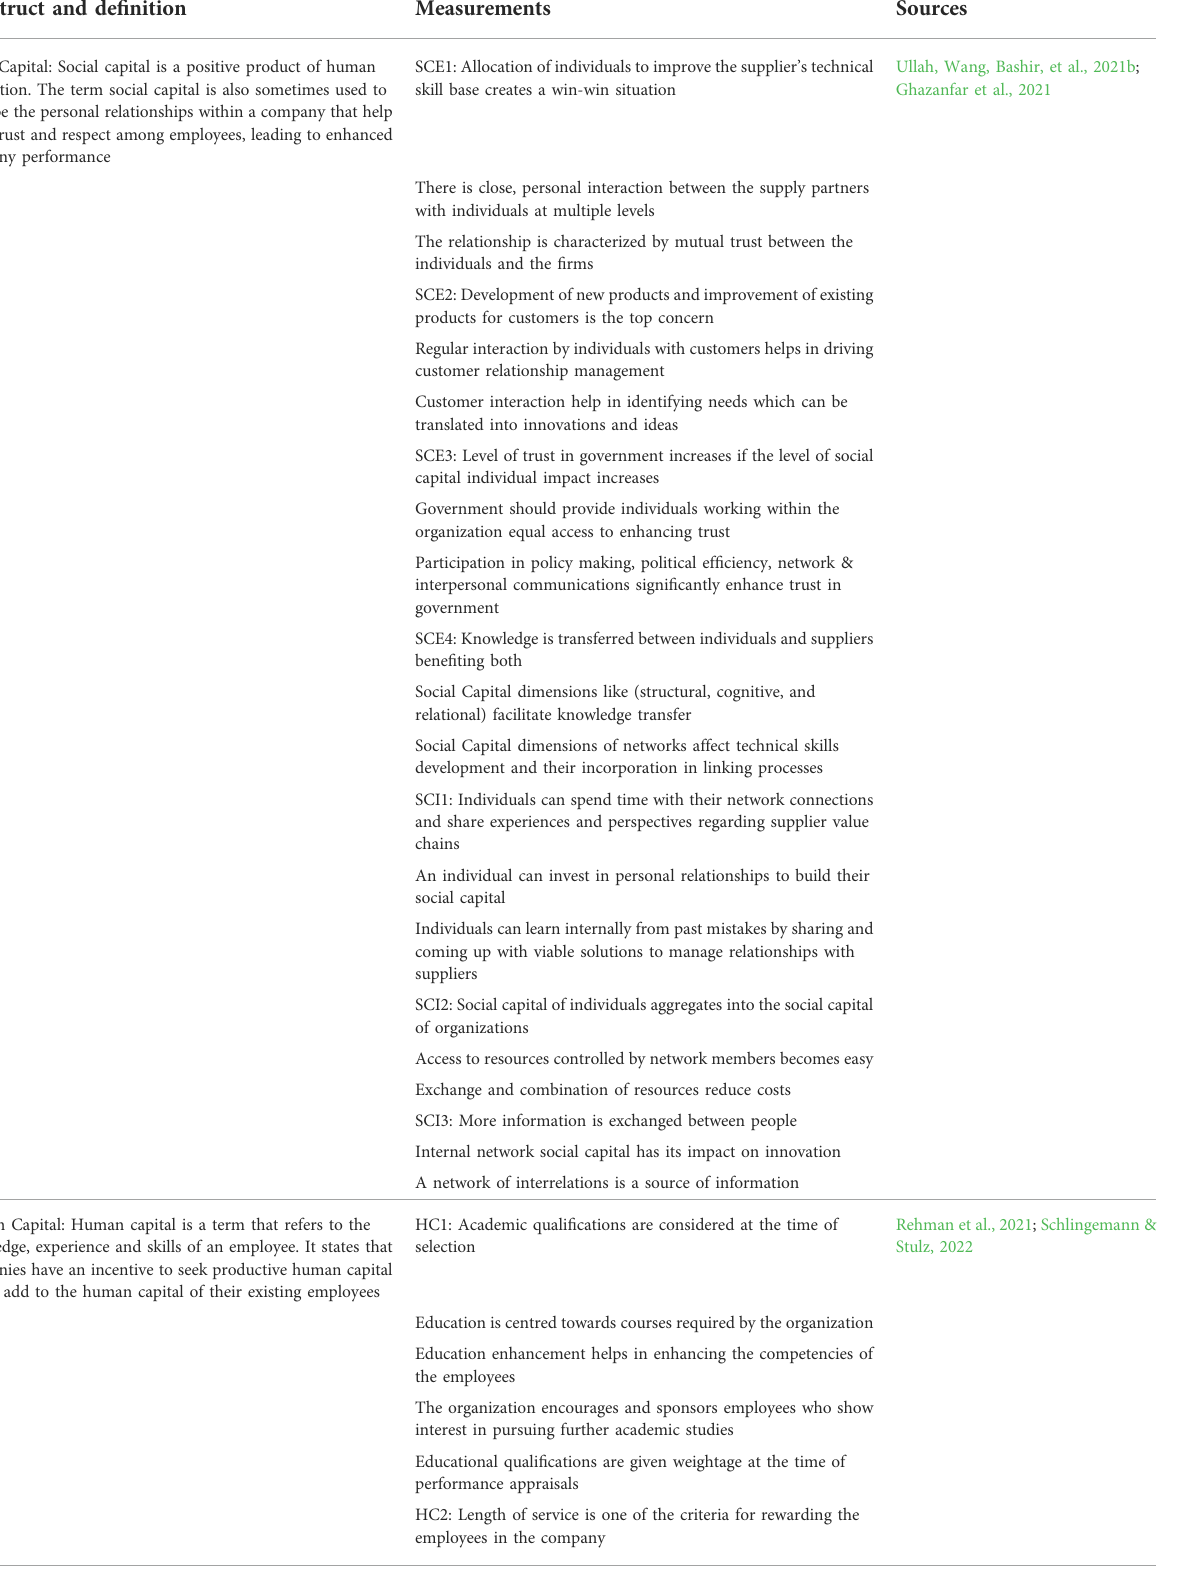
TABLE 1 Construct developed in the research